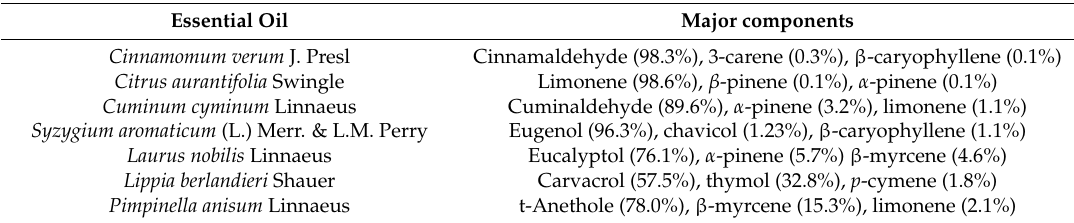
Table 1. Main essential oil components of the seven essential oils investigated for larvicidal toxicity against the filariasis vector Culex quinquefasciatus